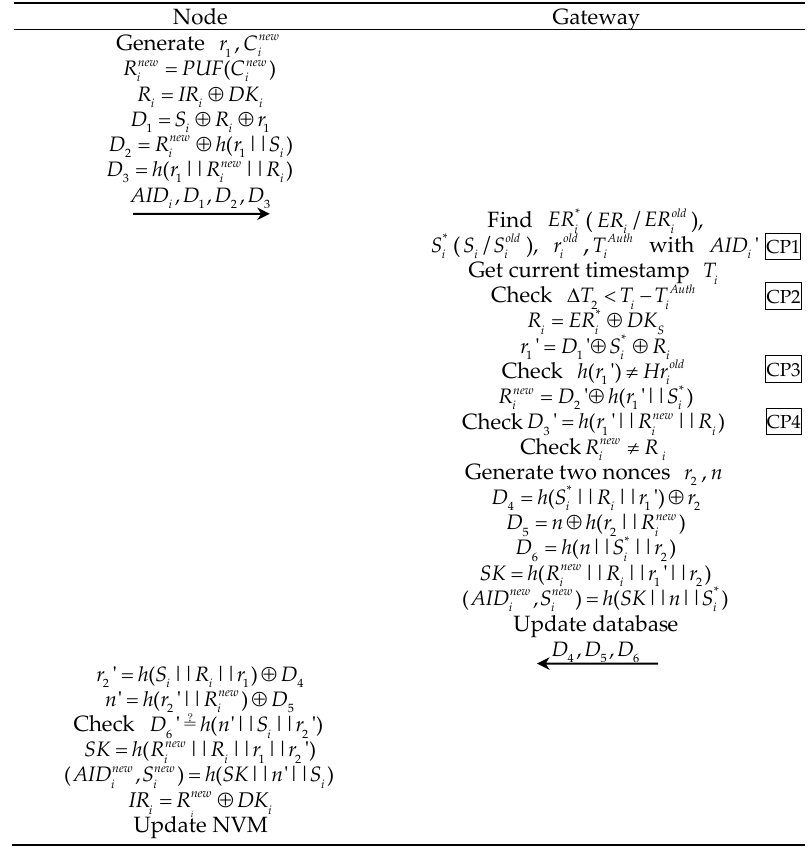
Figure 4. PEASE protocol steps in the authentication phase (unsecure channel). (CP1-4 stand for checkpoints for attack detection; this will be described in Section 4.2)